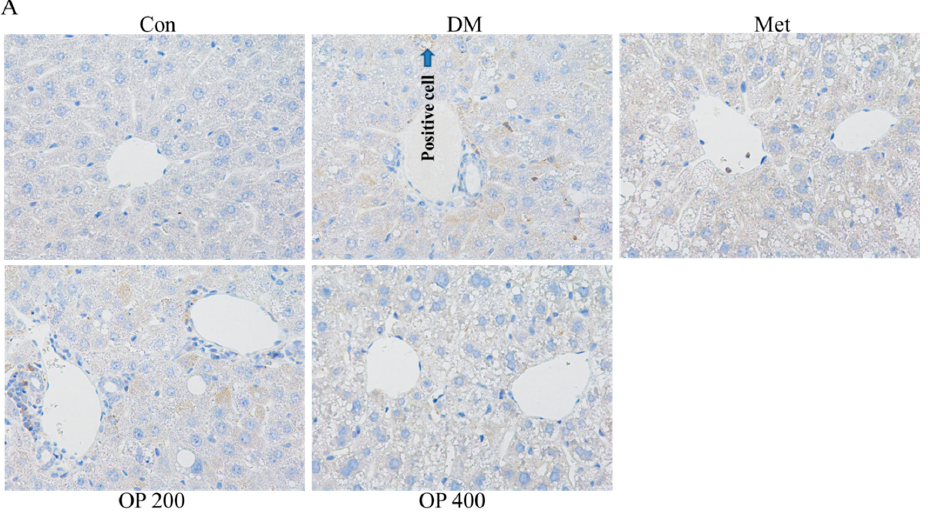
Figure 9. Effect of OP treatment on the T2DM-induced nicotinamide adenine dinucleotide phosphate oxidases 2 (NOX2) expression in the liver (Diaminobenzidine (DAB) staining, 200×). ( A ) Representative photographs were shown for the mouse livers in the different groups. ( B ) IOD of the NOX2 by Image-Pro Plus software 6.0 analysis. Results are represented as mean ± SD (n = 3). ## p < 0.01 vs control, * p < 0.05 vs model. 3. Discussion Plant polysaccharides have been explored and demonstrate significant biological activities, which account for their applications in complementary and alternative medicine. Polysaccharide, an important ingredient of Abelmoschus esculentus (L.) Moench, has been reported to have an excellent hypoglycemic activity and antioxidant activity [16,17], however, it is not at all certain whether OP has promoted the elimination of a high glucose impact on the body’s immune response, or whether OP has inhibited the activation of oxidative stress activation pathways. Therefore, in this paper, we mainly studied the anti-T2DM effect and the underlying mechanism of OP. HFD feeding combined with an i.p. lower dose of STZ showed a significant rise in the blood glucose level in both biochemical and histopathological analysis, which is conformed to the typical phenomenon of T2DM in humans [18]. This aforesaid finding is consistent with our experimental data, which measured a high blood glucose level and demonstrated pathophysiological development. Hence, this mice model would be a more suitable option to study drugs against T2DM. Consumptive thirst is one of the most important clinical manifestations of T2DM. Body weight loss is due to the excessive decomposition of protein and fat, which cannot be utilized by the tissues as a body energy source [19]. As a result of the blood glucose rise, plenty of water is required for the body to excrete excess glucose through the urine. The increase in food consumption is caused by a decrease in insulin sensitivity and the glucose utilizing ability of tissues, thereby leading to a long